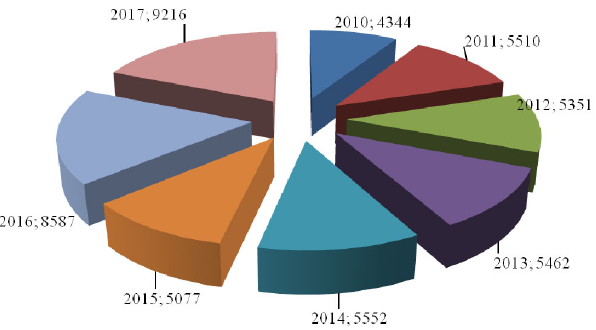
Fig. 1. Catching the aquatic bioresources in the in- land water bodies of the Odessa region. (according to the State Statistics Committee of